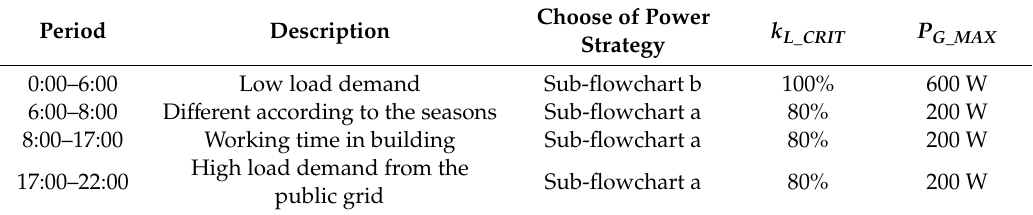
Table 2. Scenario parameters.